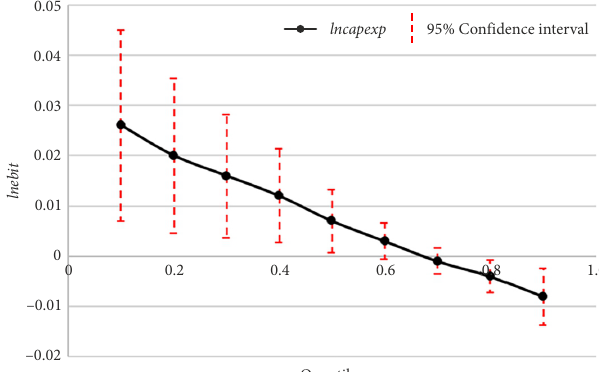
Figure A3. Effect of expanding production capacity for existing products on economic